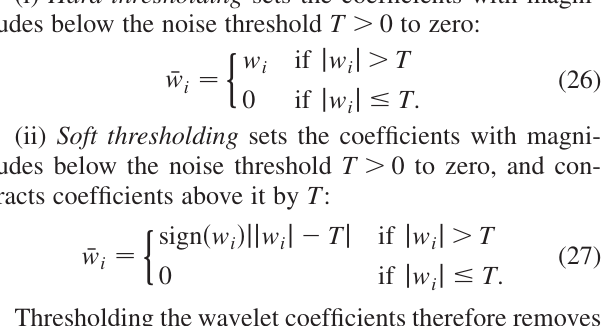
FIG. 3. Accuracy (measured by the IMSE) for the gridded distribution deposited using NGP (green line), CIC (blue), TSC (black) CDS, and the full (nontruncated) Monte Carlo cosine expansion (red) as a function of the number of particles N for the sinusoidally modulated flattop distribution used in Sec.